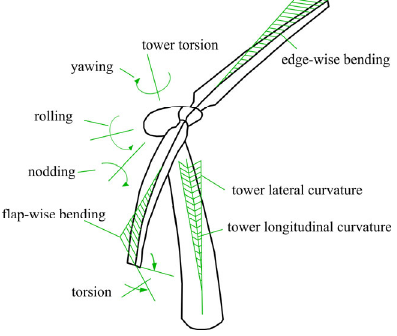
Figure 1. Degrees of freedom (in green) of the wind turbine (adapted from Hau,